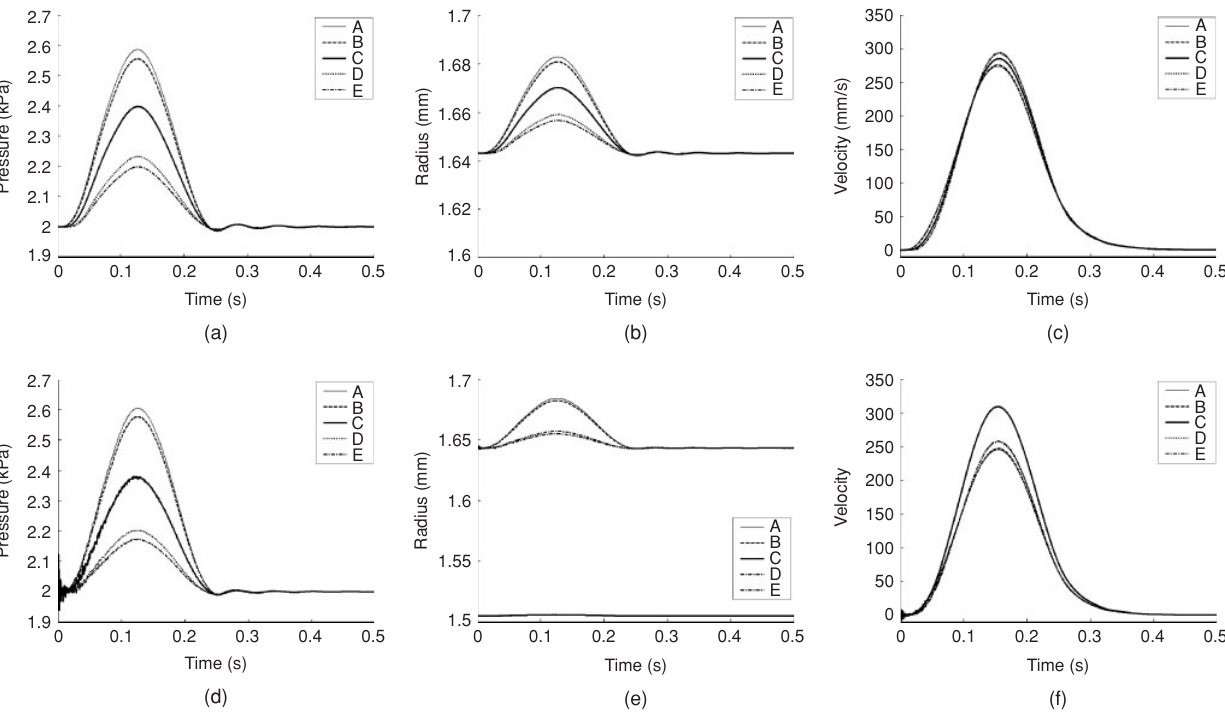
Figure 7 Time versus varying pressure, radius and flow velocity at various points (A–E) along the vessel segment 2 in the unstented ((a)–(c)) and stented ((d)–(f)) cases with sinusoidal inlet pressure variation (Simulation II). See Figure 1 for the positions of these points in the network. Note that the radius at point C in the middle of the stented vessel is just over 1.5 mm (the radius of the stent).